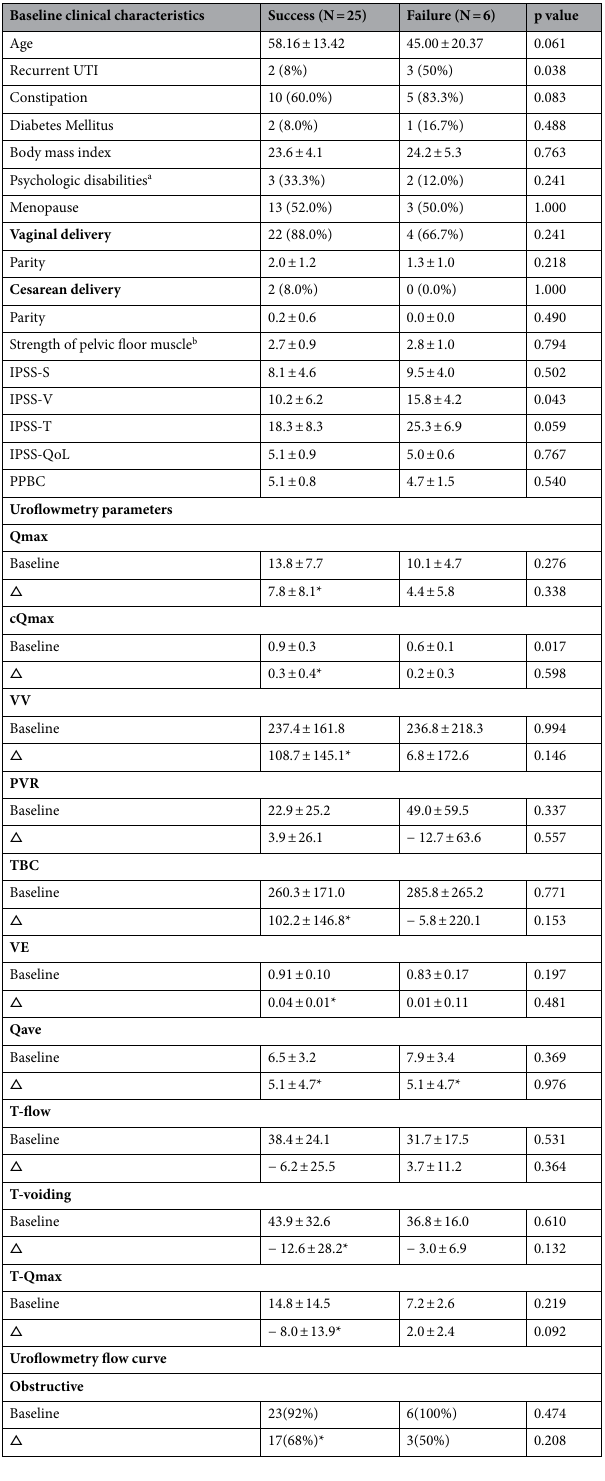
Table 2. Clinical characteristics and uroflowmetry profiles in patients with different treatment outcomes. UTI urinary tract infection, IPSS International Prostate Symptom Score, IPSS-S IPSS storage subscore,